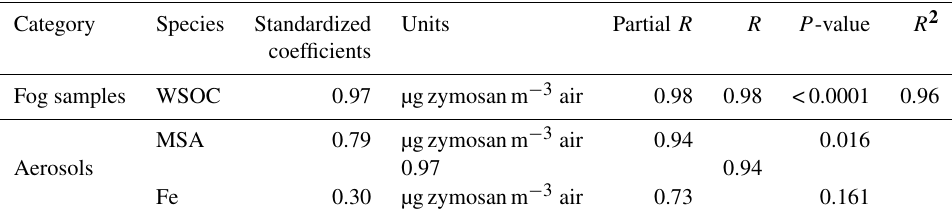
Table 3. Output of multiple linear regression (MLR) analysis using ROS activity as the dependent variable and ambient concentrations of the measured chemical species as independent